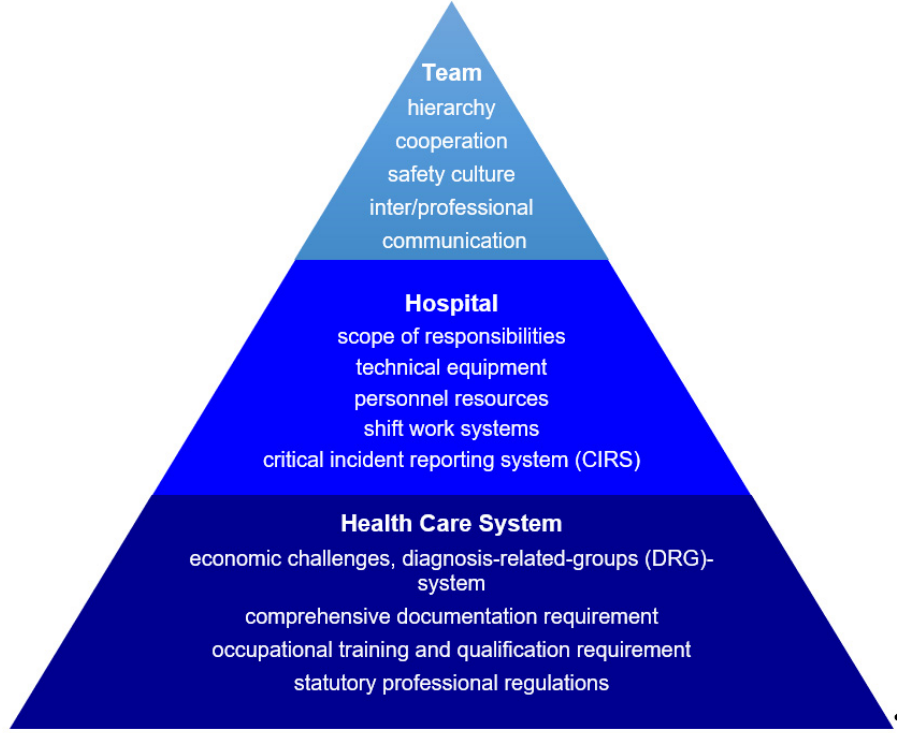
Figure 1. Structural levels affecting patient